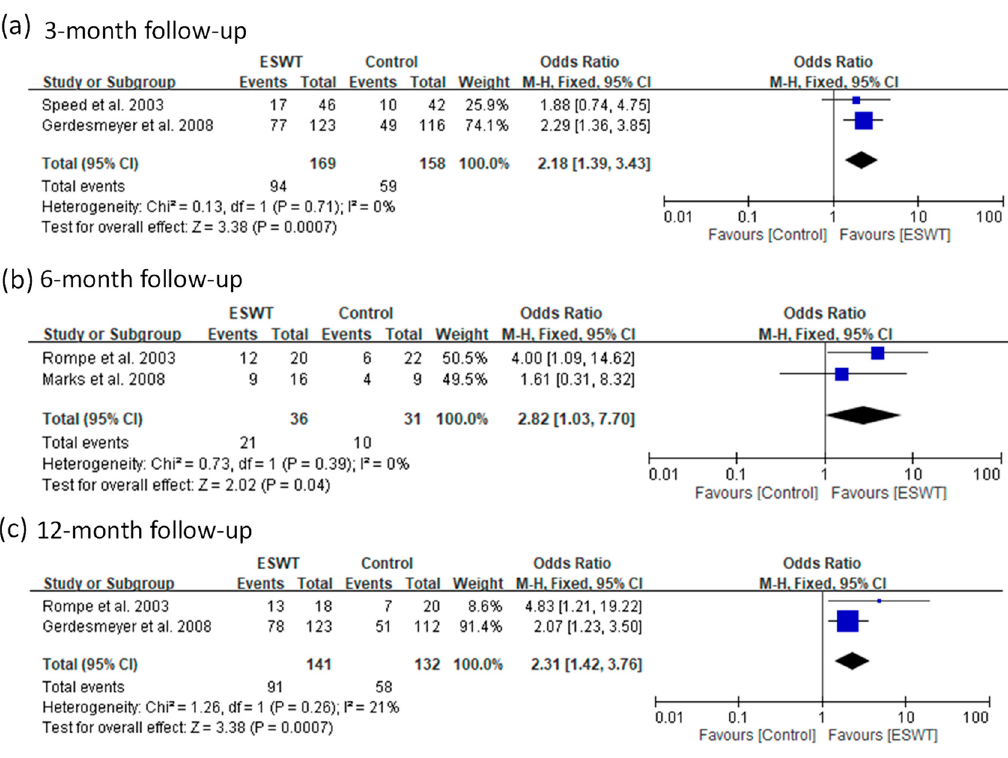
Figure 5. Forest plots of treatment success rates in medium-energy ESWT and placebo-controlled groups at 3-month ( a ), 6-month ( b ), and 12-month ( c ) follow-ups.